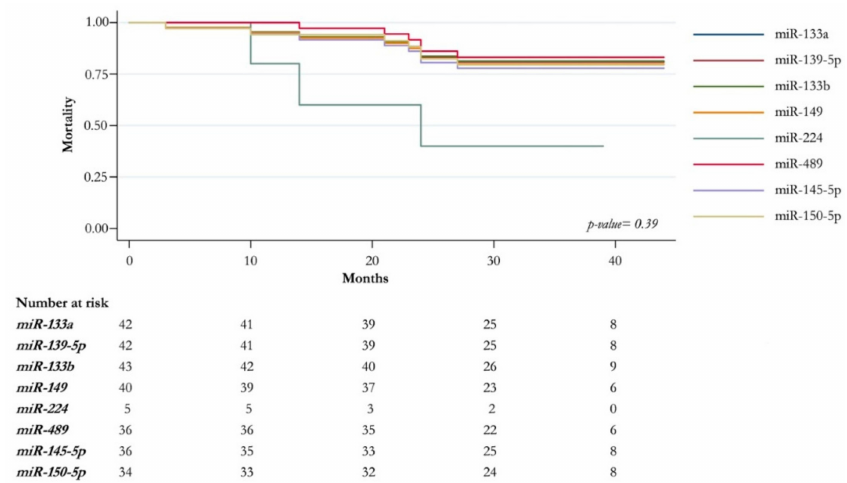
Figure 4. Survival analysis for miRNAs deregulated in CRC. Overall survival is shown according to up and down expression level (fold change) of miRNAs